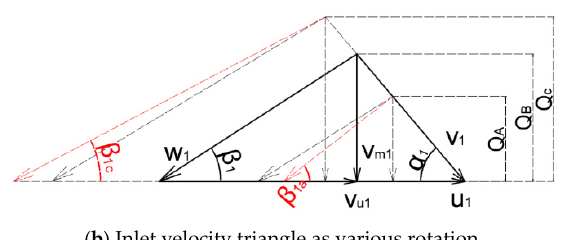
Figure 5. Turbine rotor triangle velocity.